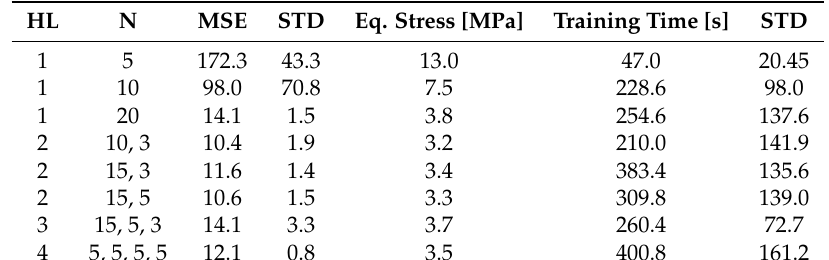
Table 4. Performance of a selection of tested ANN architectures showing the number of hidden layers (HL), number of neurons (N), average achieved MSE (mean squared error), equivalent error in MPa and training time. 10 tests were conducted for each architecture.